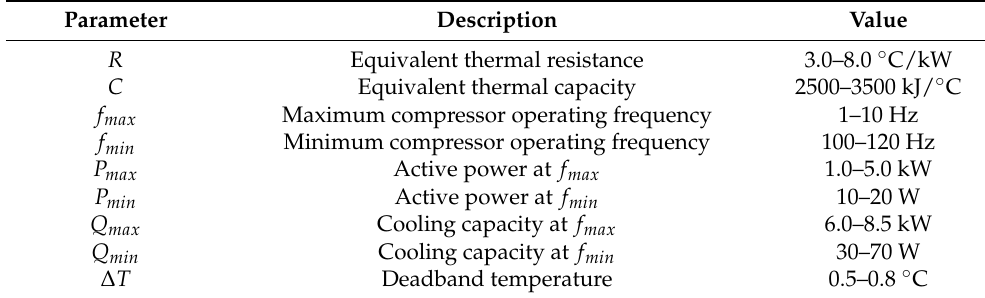
Table 2. Main parameters of the aggregated IAC